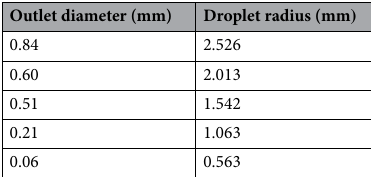
Table 1. Droplet generator specifications.